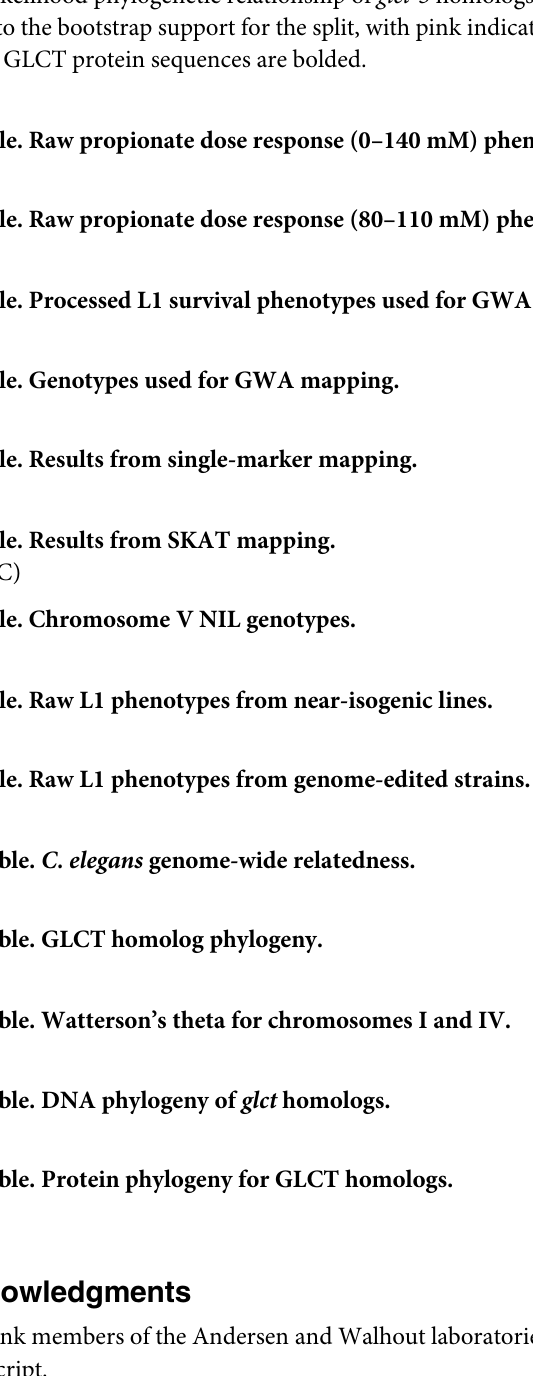
S8 Fig. Phylogenetic relationship of GLCT-3 homologous protein sequences. The maxi- mum likelihood phylogenetic relationship of glct-3 homologs is shown. Branch colors corre- spond to the bootstrap support for the split, with pink indicating higher support. The C . elegans GLCT protein sequences are bolded.